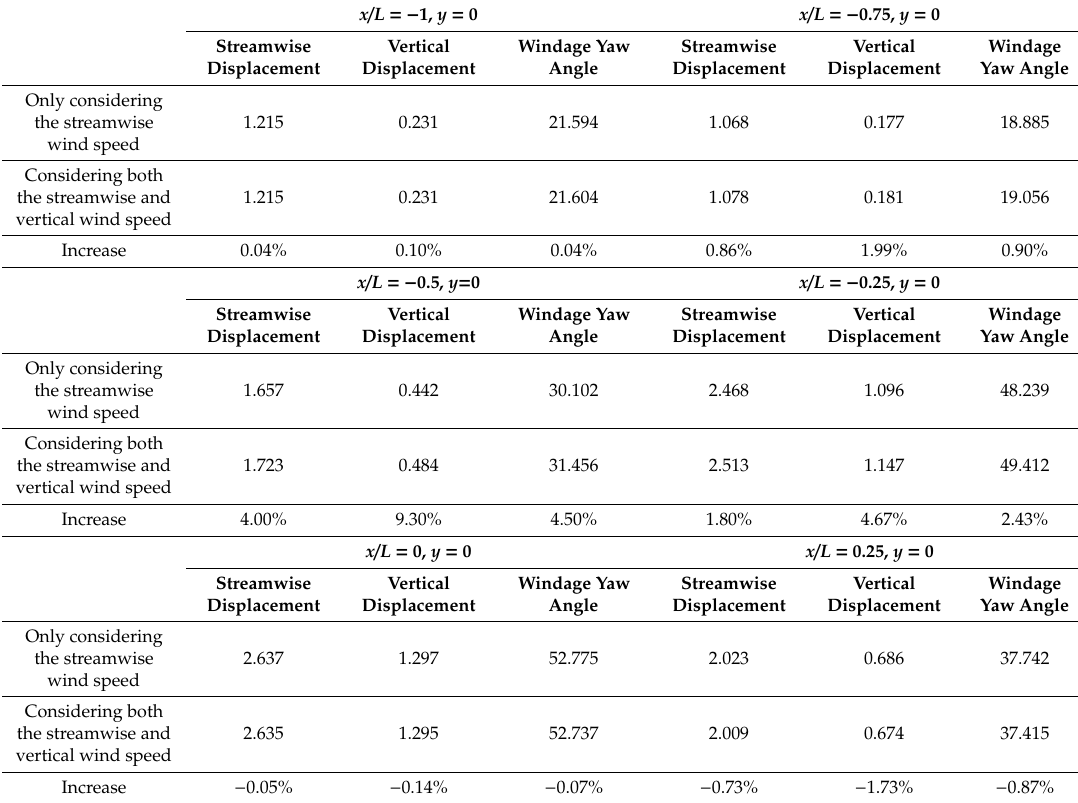
Table 3. The wind-induced response of the lowest point of the jumper